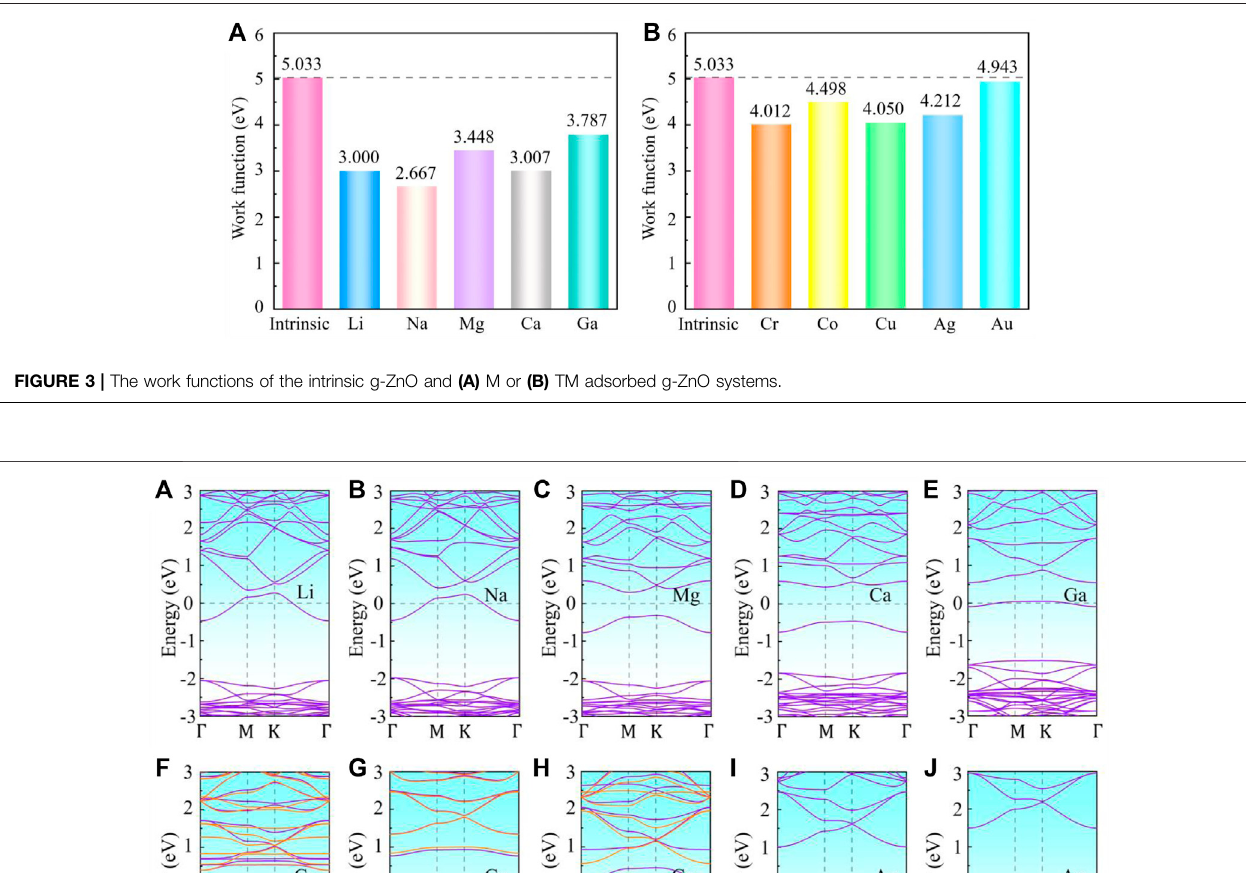
Frontiers in Chemistry |